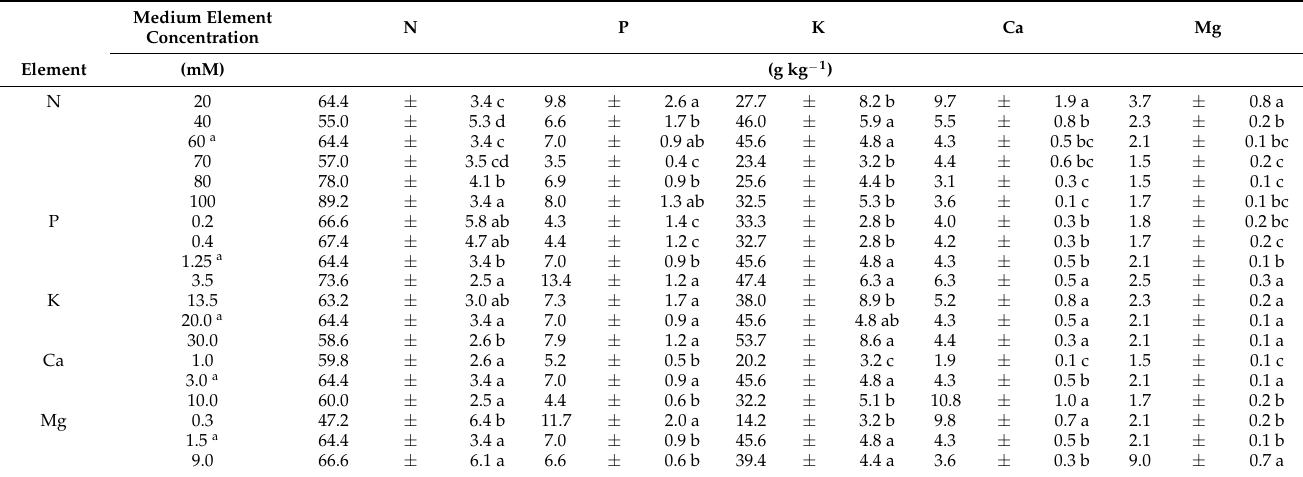
Table 3. Effect of changes in nutrient element concentrations in MS medium on nutrient content in shoots of potato plants in vitro.